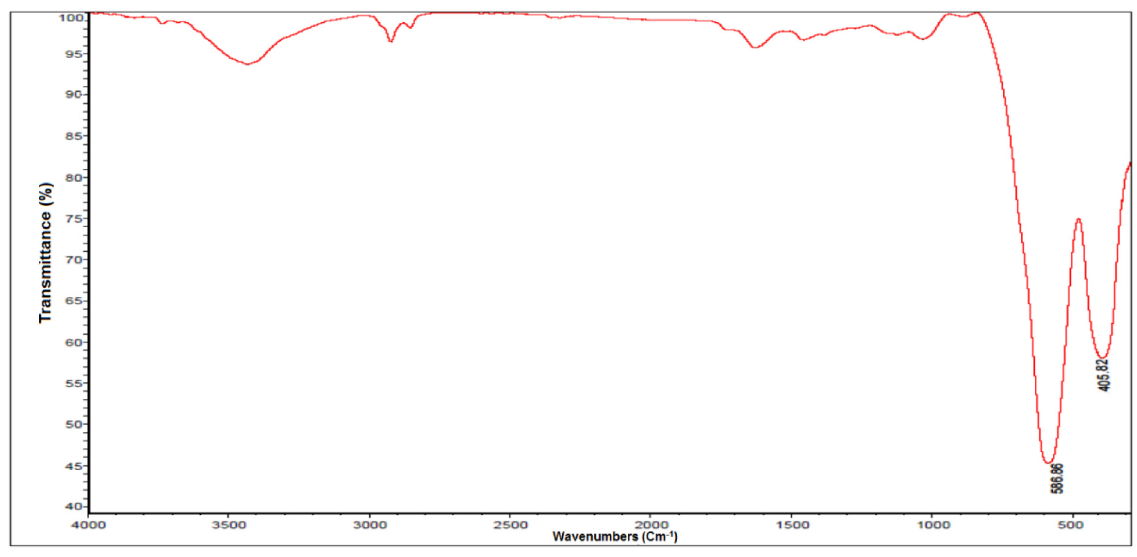
Figure 3: FT-IR spectrum of the CuFe